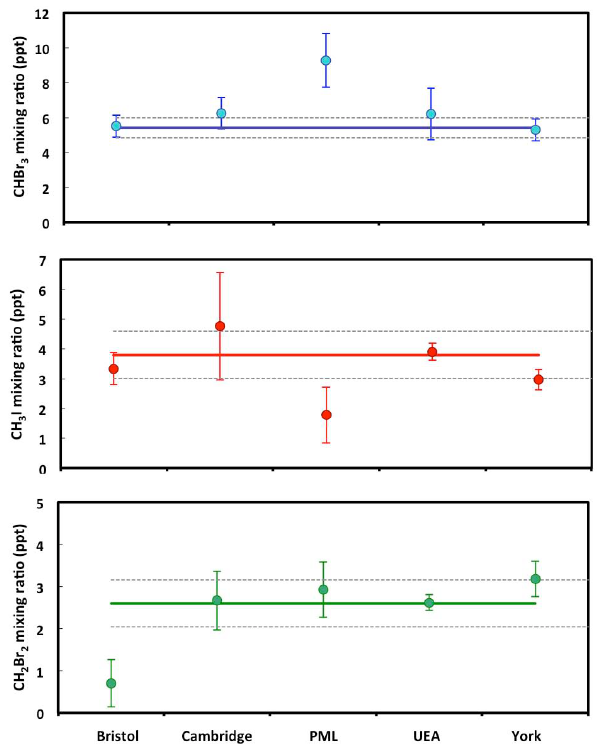
Fig. 1. CHBr 3 , CH 3 I and CH 2 Br 2 mixing ratios determined by each research group, with estimated 2 σ measurement uncertain- ties. The solid line in each plot corresponds to the NOAA-assigned mixing ratio, and the grey dotted lines indicate the estimated 2 σ uncertainty in the NOAA